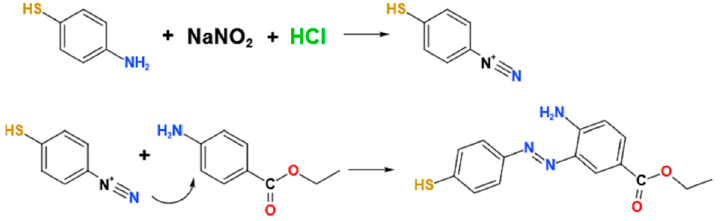
Figure 1. SERS spectra of benzocaine at the concentration of 1 mg/mL with Ag NPs at the volume ratio of 1:100, 1:50, 1:30, 1:20, and 1:5. Raman spectra of benzocaine solid and Ag NPs. Excitation wavelength: 532 nm. The inset is the structure of benzocaine.